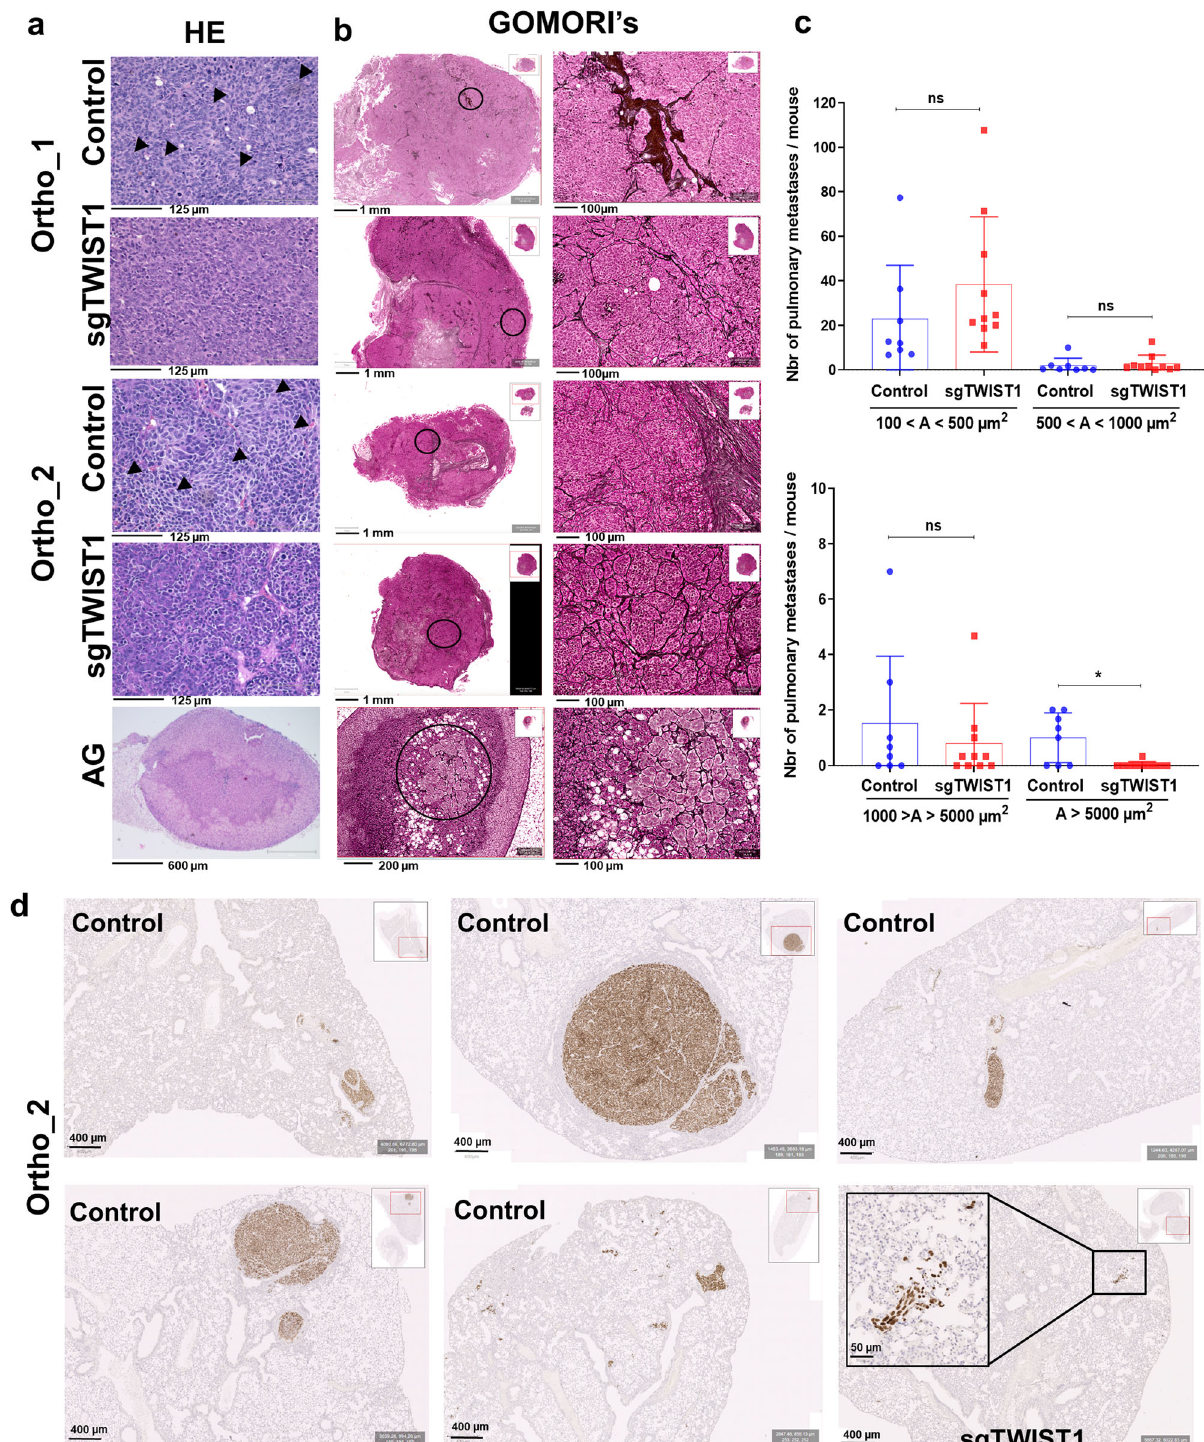
TWIST1 alters the level of expression of genes involved in tumor-stroma crosstalk . Cancer cells establish a reciprocal inter- cellular signaling network and communicate with stromal and immune cells via the production of soluble paracrine factors and their cognate receptors. This complex signaling network shapes the TME to sustain cancer cell proliferation and invasion. To address whether TWIST1 alters the expression of factors involved in cell − cell communication, DE genes annotated as cytokines, chemo- kines, growth factors, in fl ammatory mediators and their receptors,